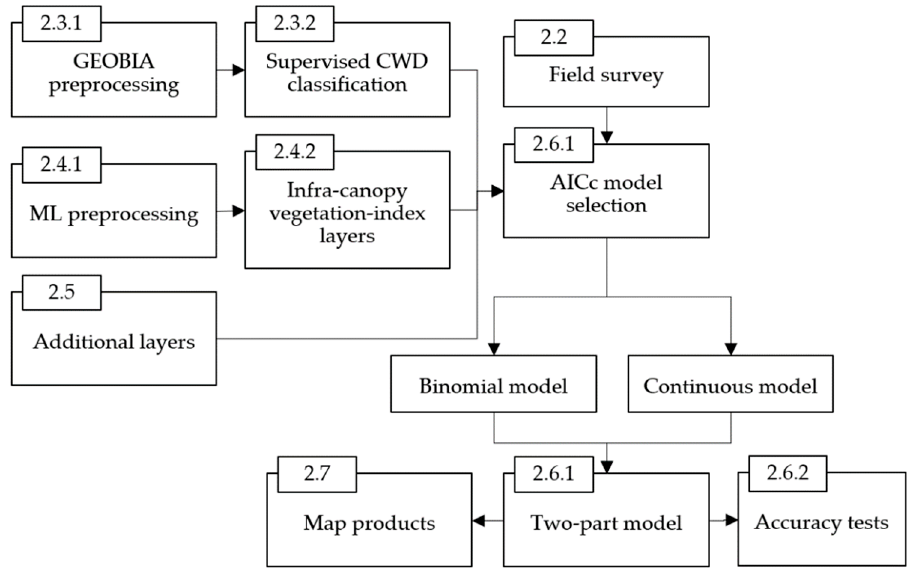
Figure 1. Workflow chart of this study with the sub-section numbers where each step is explained in this document. We mapped non-occluded coarse woody debris (CWD) via a geographic object-based image analysis (GEOBIA) workflow. Occluded CWD quantities were estimated using multispectral LiDAR (ML) vegetation indices from underneath the canopy. We selected potential models for CWD volume using the small sample Akaike information criterion (AICc) as an indicator for model predictive power.